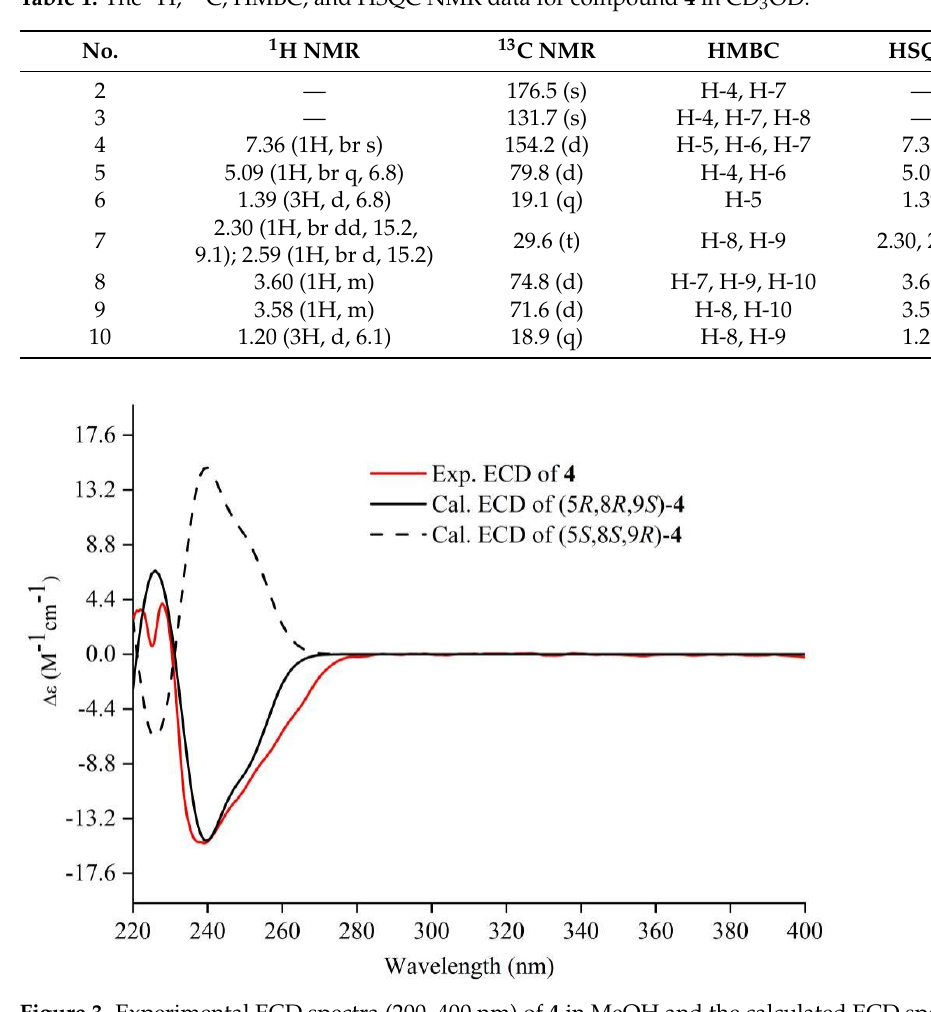
Figure 3. Experimental ECD spectra (200–400 nm) of 4 in MeOH and the calculated ECD spectra of the model molecules of 4 at the PBE0/def2-TZVP level.